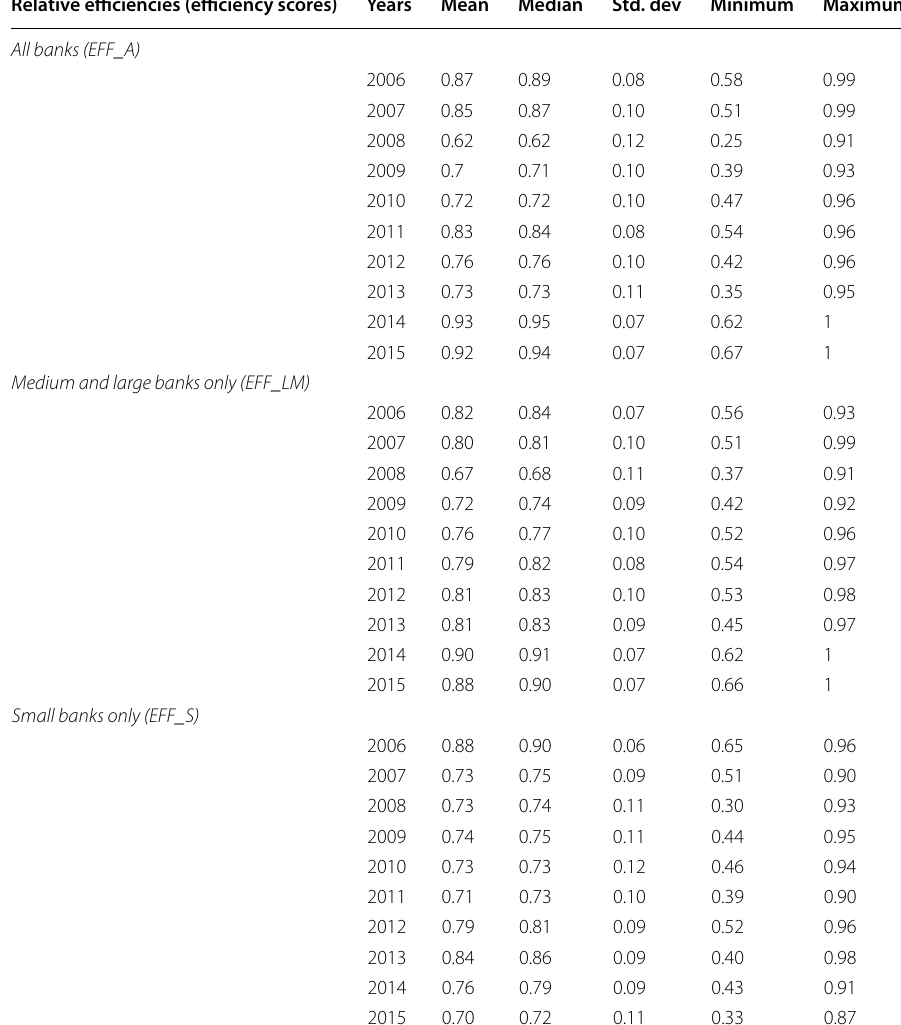
Table 6 Relative efficiency of banks by size categorization and